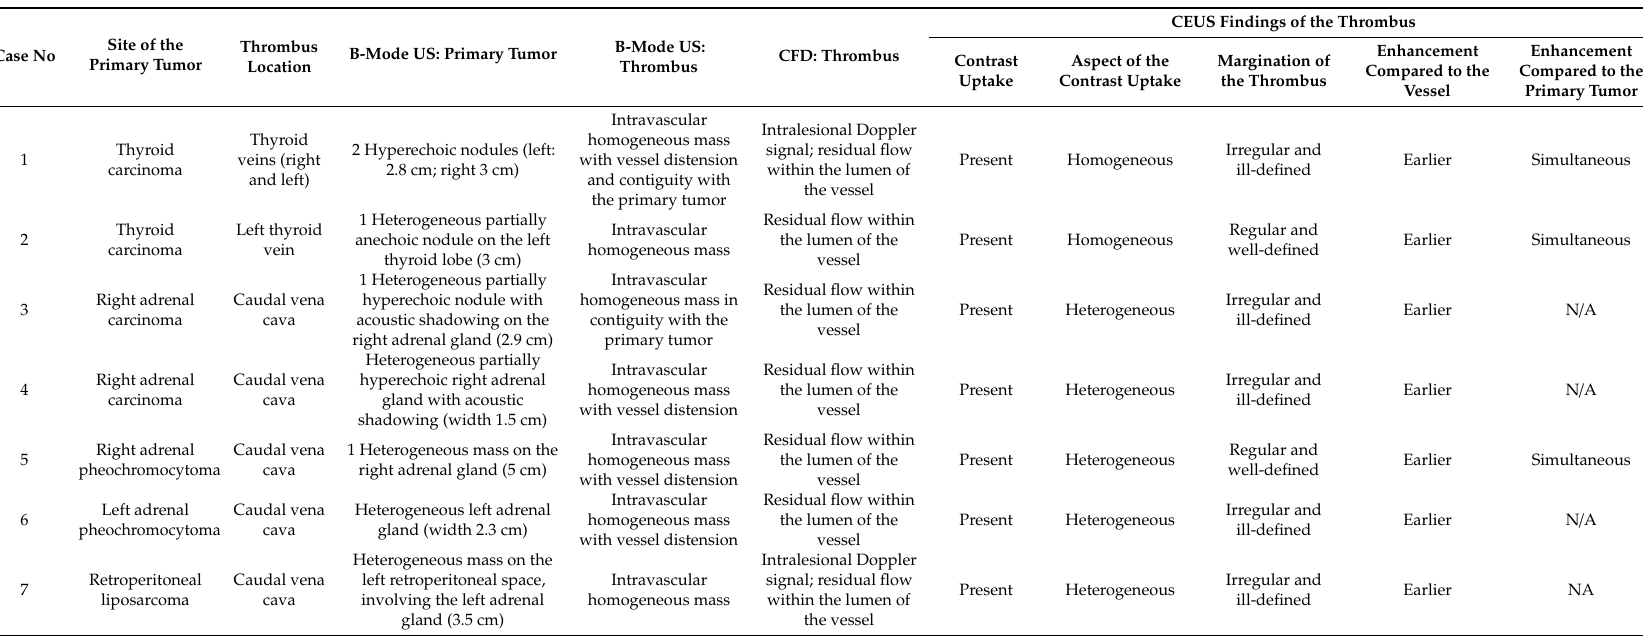
Table 2. Two-dimensional ultrasound (US), color flow Doppler (CFD) and contrast-enhanced ultrasonographic (CEUS) findings in a group of dogs with neoplastic venous